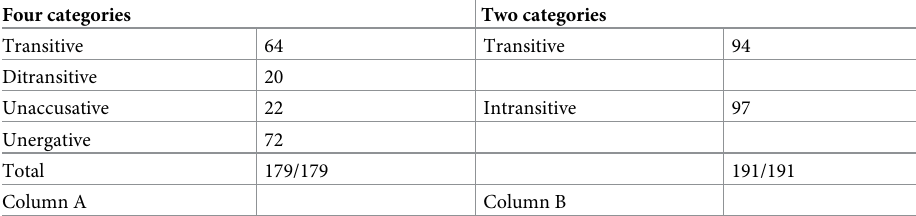
Table 1. Distribution of non-signer transitivity determinations in four and two